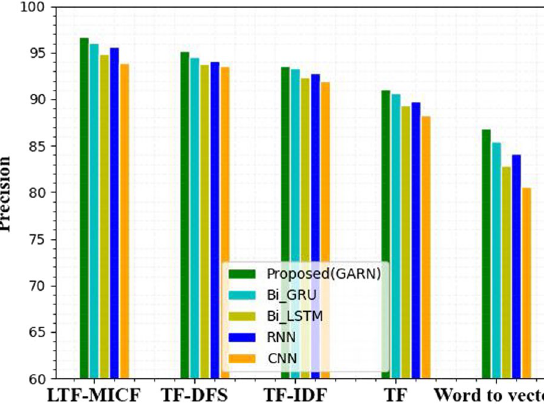
Fig. 5 Precision of the classifiers with term weight schemes